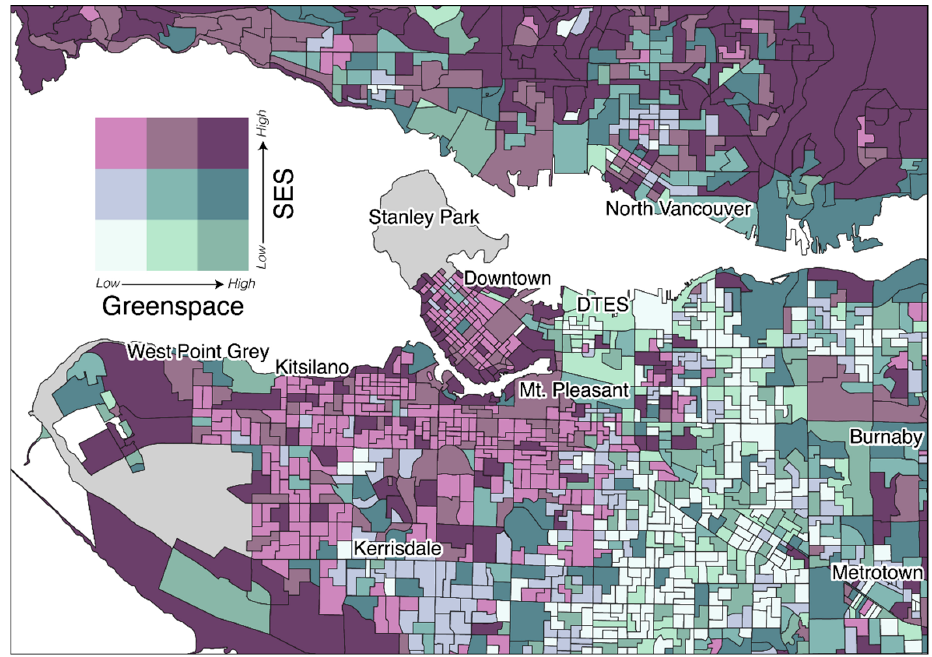
Figure A1. Bivariate map illustrating the spatial relationship between neighborhood SES and green/blue space. The amount of green/blue space within a DA determined the area’s score. A tertile of VANDIX scores informed the SES in a DA. Regions shaded in gray did not have SES data since they are federal and provincial lands.